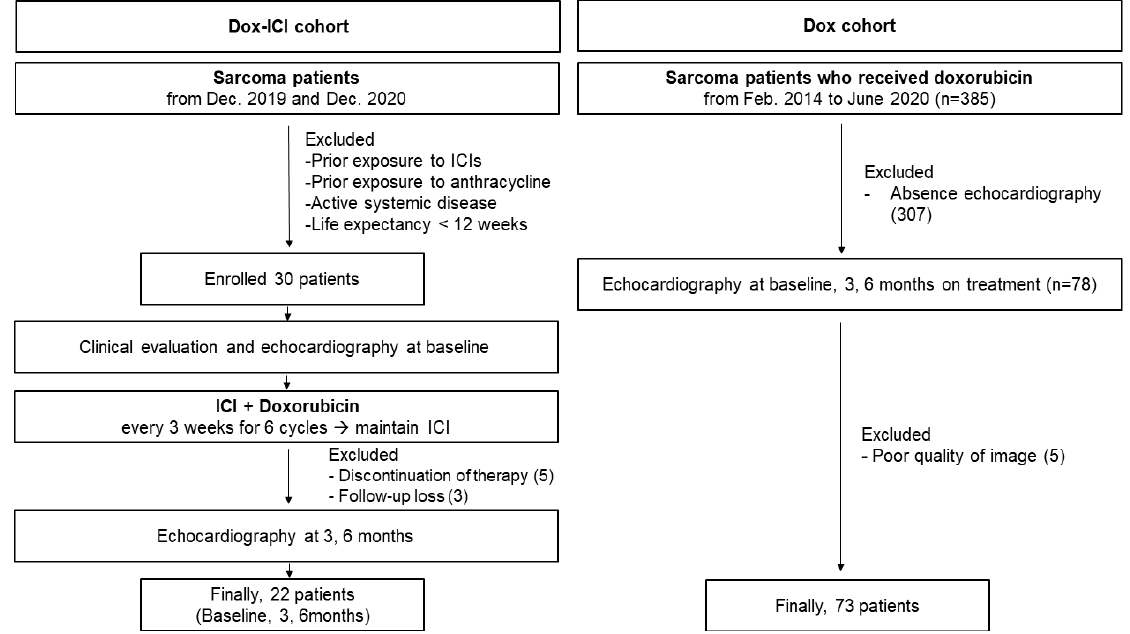
Figure 1. A graphical representation of the patient selection process. Table 1. Baseline characteristics of the study population.